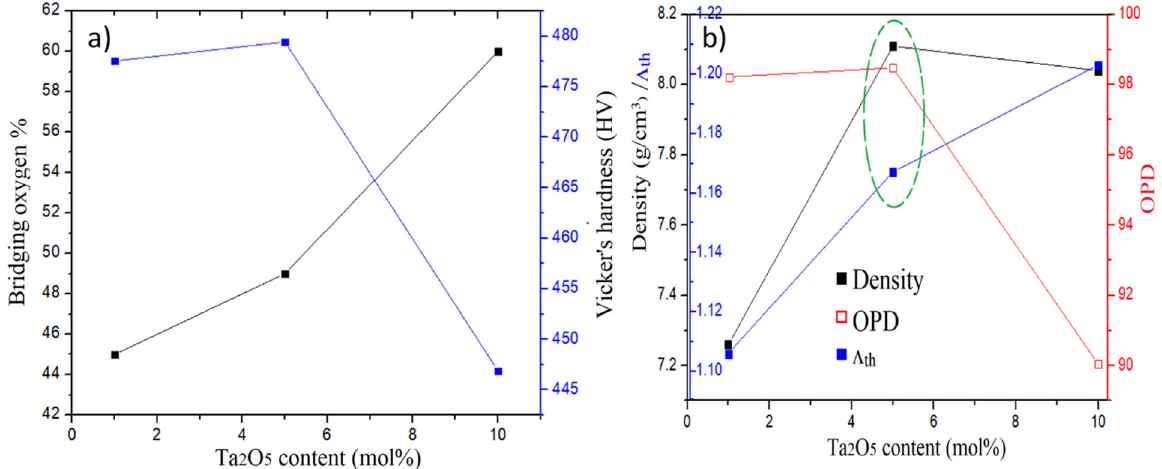
Figure 6. Composition dependence of bridging oxygen numbers, Vickers hardness ( a ) and density, OPD , and optical basicity ( b ) of glasses.